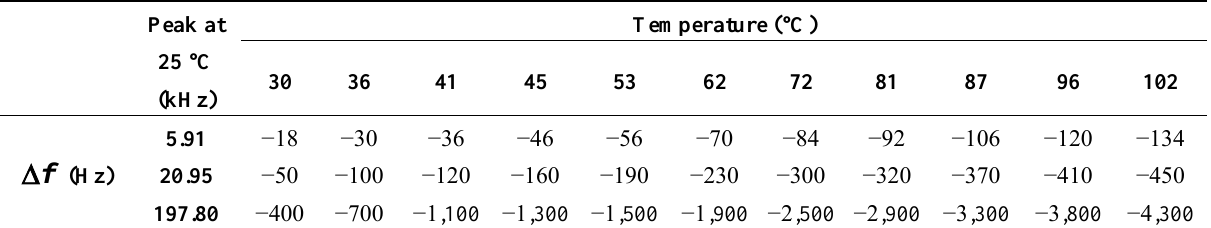
Table 1. Frequency shifts ( f  ) for three resonance peaks at different